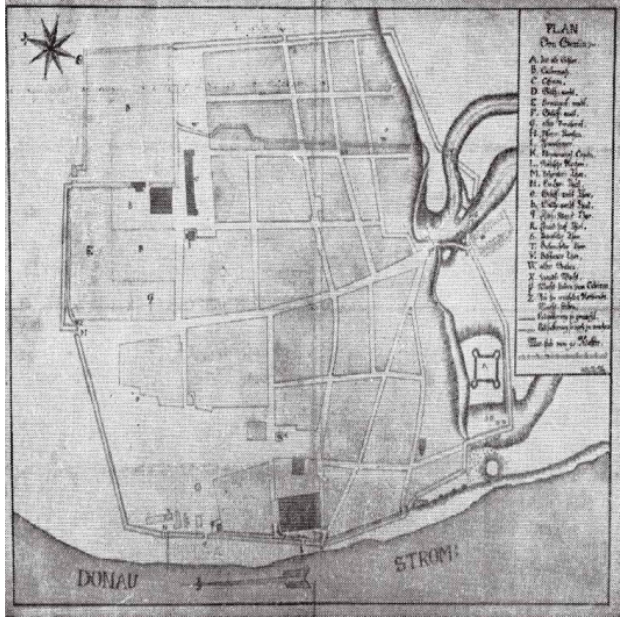
Figure 1. Johan Michael Klotz’s plan of the City of Zemun, 1754.